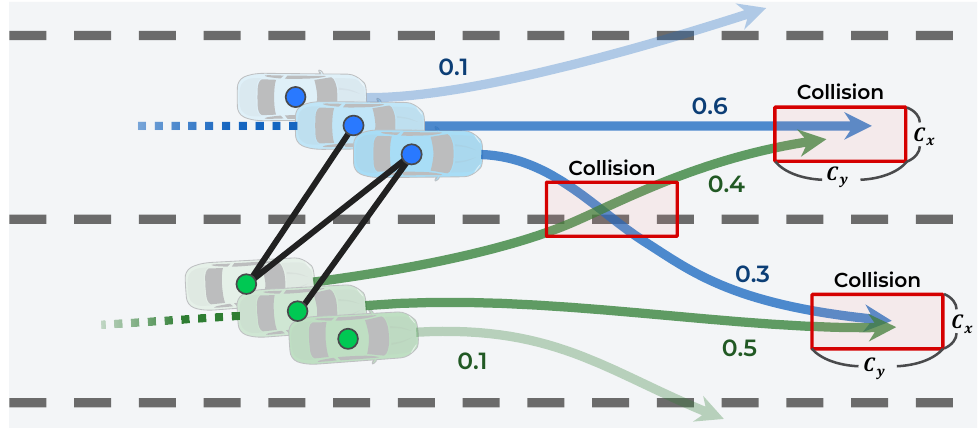
Figure 6. Graph construction based on collisions among trajectories predicted in Stage